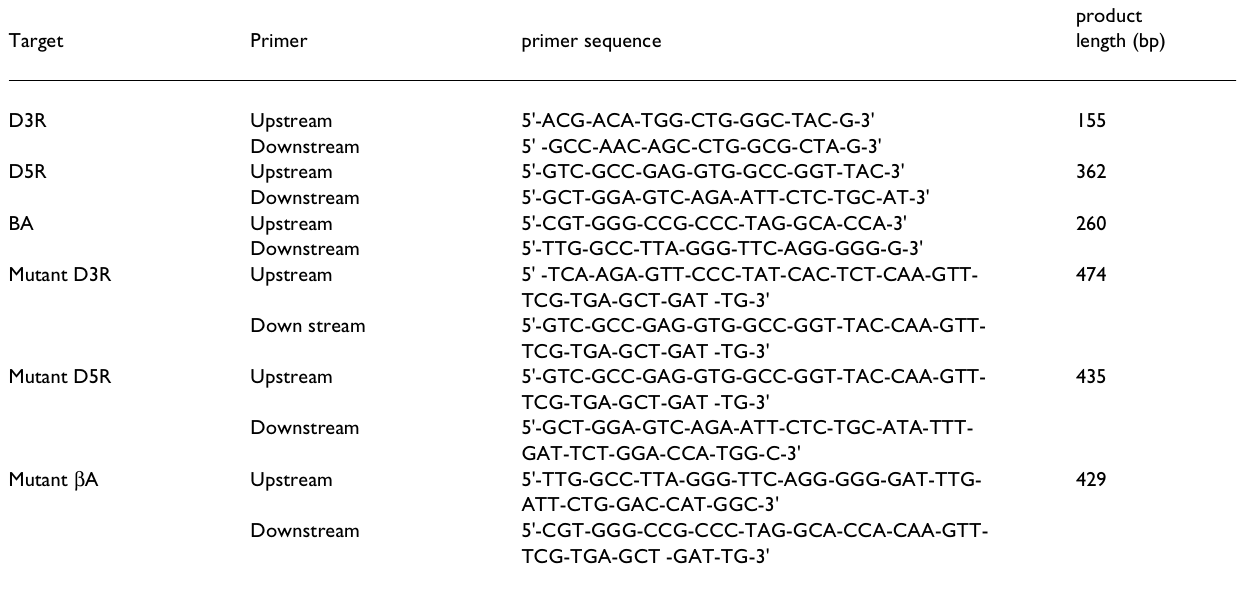
Table 2: Primer used to amplify the dopamine receptor, beta-actin and their competitive mutants